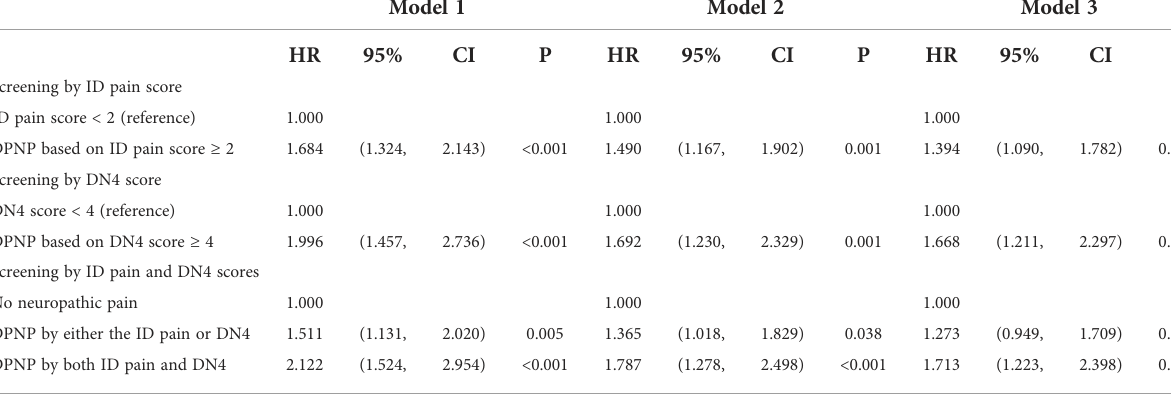
TABLE 3 Cox proportional hazard regression models for the association between DPNP and